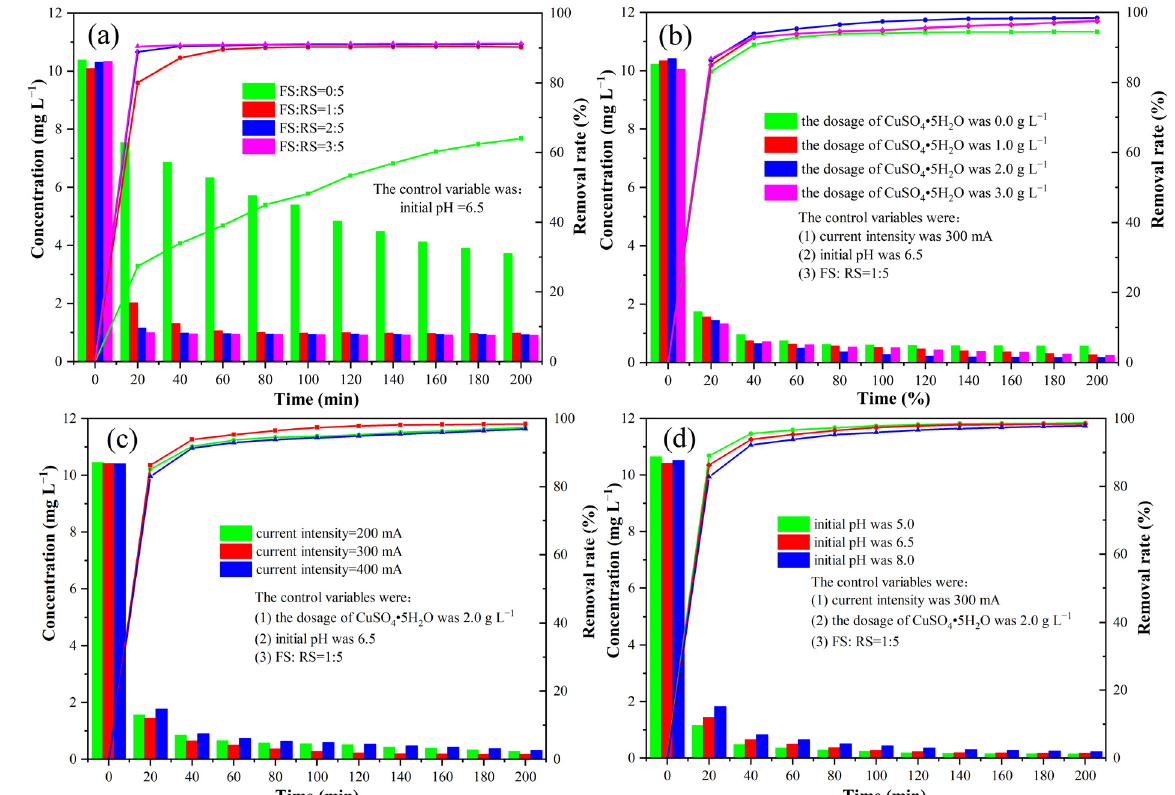
Figure 7. The influence of factors on removal rate of 2-naphthol: ( a ) the ratio of FS to RS; ( b ) the dosage of CuSO 4 •5H 2 O; ( c ) the current intensity; ( d ) the initial pH of 2-naphthol wastewater.